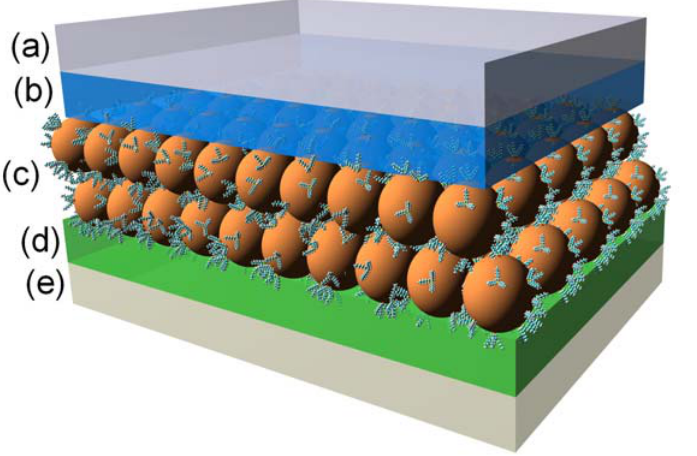
Figure 7. Schematic of a light emitting device incorporating quantum dots: (a) cathode, (b) electron transporting layer, (c) organic ligand functionalized quantum dots, (d) hole transporting layer, (e)